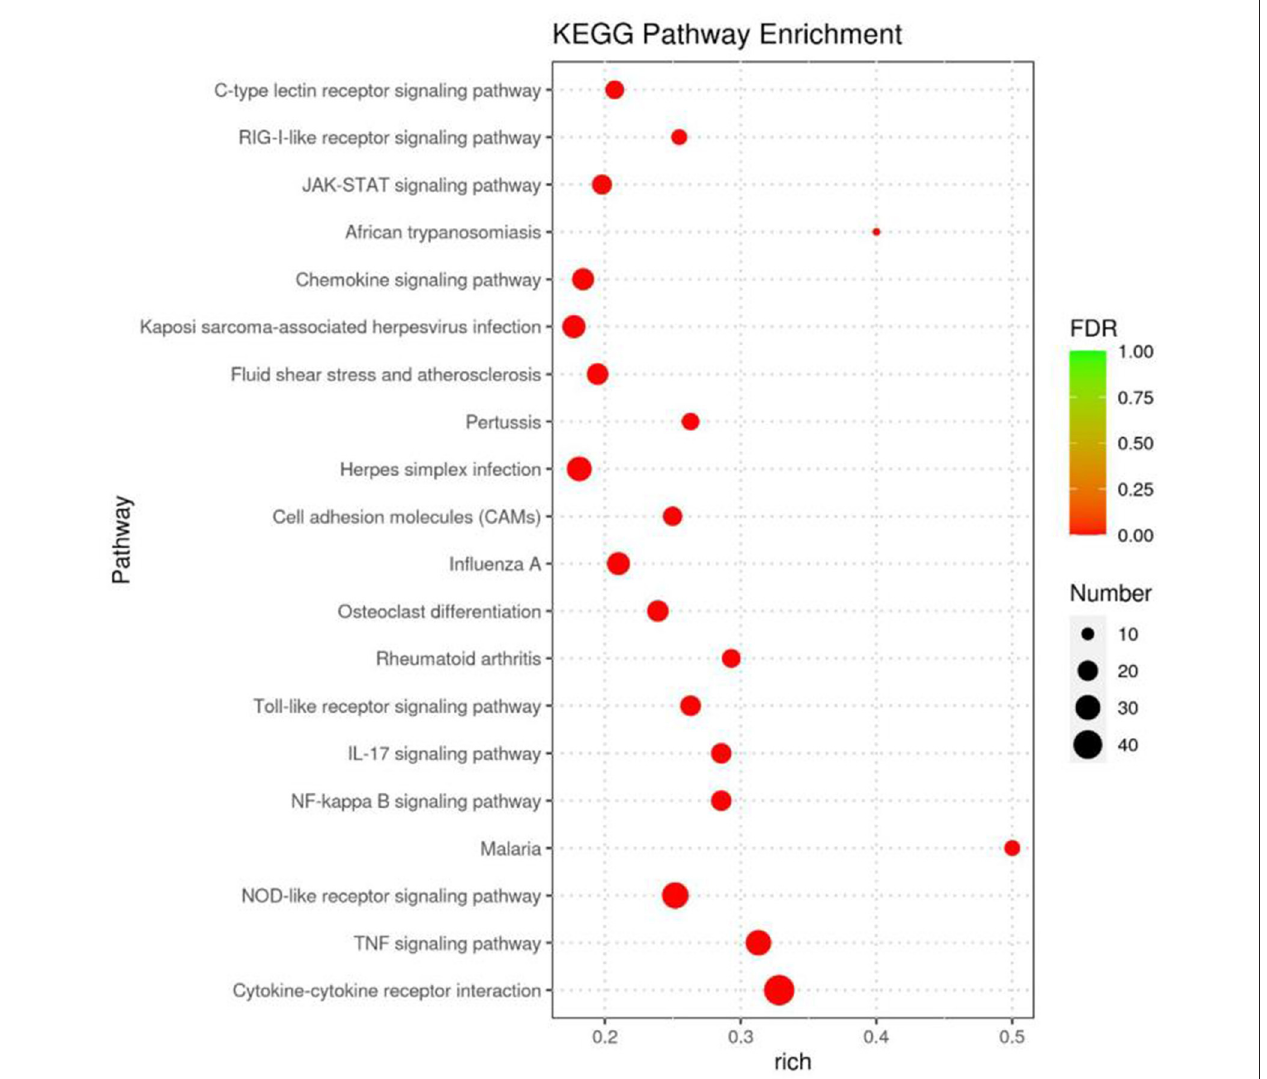
FIGURE 4 | KEGG pathway analysis for the differentially expressed genes identified to the infected groups. The bubble diagram displays the top 20 items, the x-axis shows the score of enrichment, and the y-axis shows significantly enriched pathway terms. The size of each circle represents the number of genes enriched for the given pathway, where the larger the bubble, the more differentially expressed genes are